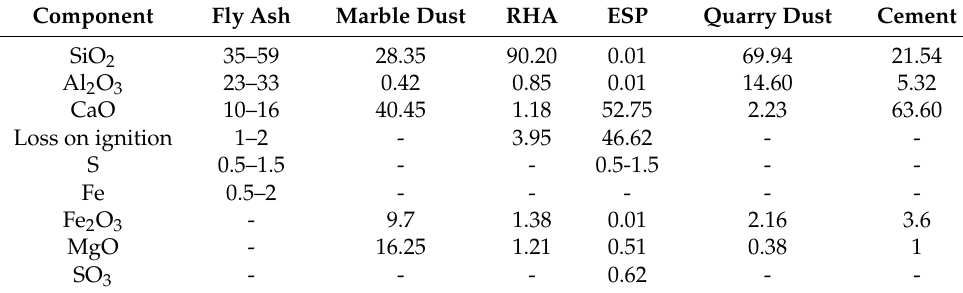
Figure 1. Waste materials: ( a ) class-C fly ash, ( b ) addition of ESP, ( c ) addition of marble dust, ( d ) quarry dust addition, and ( e ) RHA addition. Table 1. Raw materials’ chemical composition (% by weight).